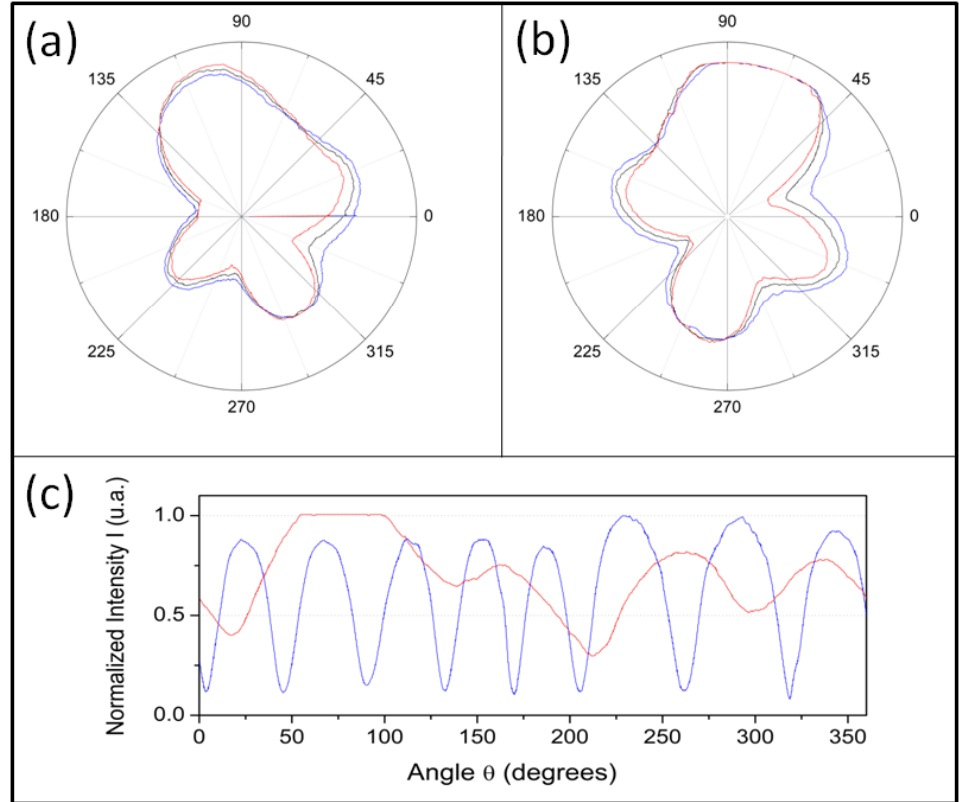
Figure 12. Graphs in polar coordinates of the circular polarization of light to the right ( a ) and to the left ( b ), for three data sets each represented with the color red, black, and blue. ( c ) Comparison between the polarization of light between the linear case represented with the curve in blue and the case of circular polarization represented in red.